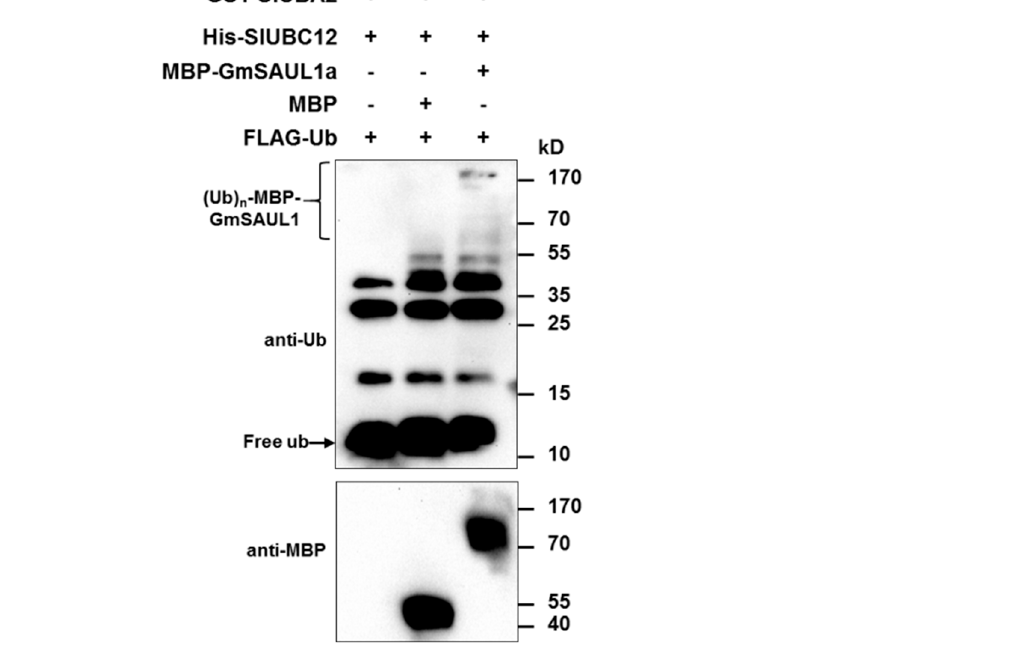
Figure 6. Gm SAUL1a is an active ubiquitin E3 ligase. The in vitro ubiquitin E3 ligase activity of Gm SAUL1a was performed in the presence of FLAG-ubiquitin (FLAG-Ub) as well as the recombinant E1 (GST-SlUBA2) and E2 (SlUBC12). Auto-polyubiquitination of MBP- Gm SAUL1a demonstrates its ubiquitin ligase activity. Anti-MBP and anti-Ub antibodies were used to detect MBP- Gm SAUL1a and free FLAG-Ub, respectively.